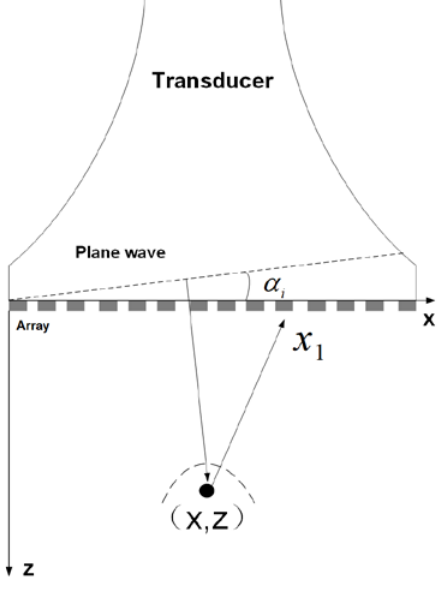
Figure 1. Schematic diagrams of tilted plane-wave transmit and receive in CPWC. The inclination angle of the plane wave is α i .